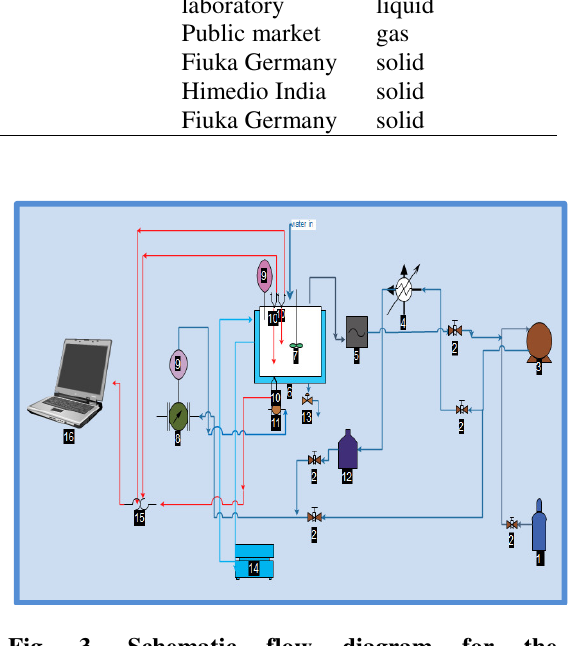
Fig. 3. Schematic flow diagram for